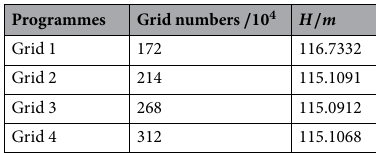
Table 3. Grid independence analysis.